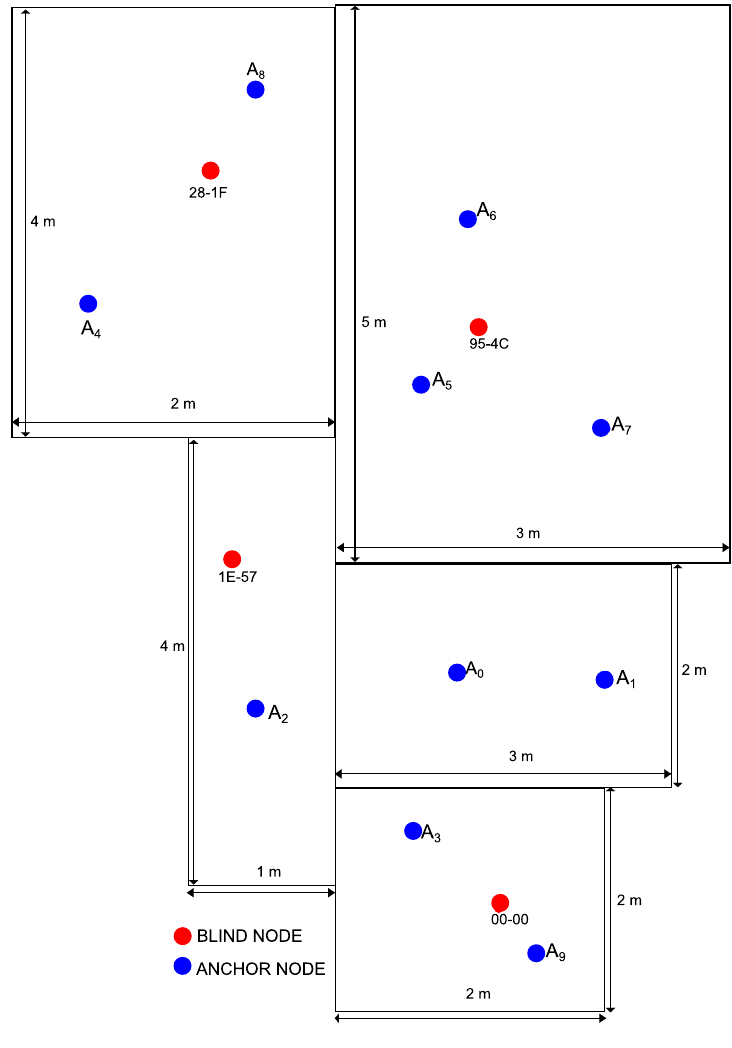
Figure 7. Position of the blind nodes and anchors for the flat.